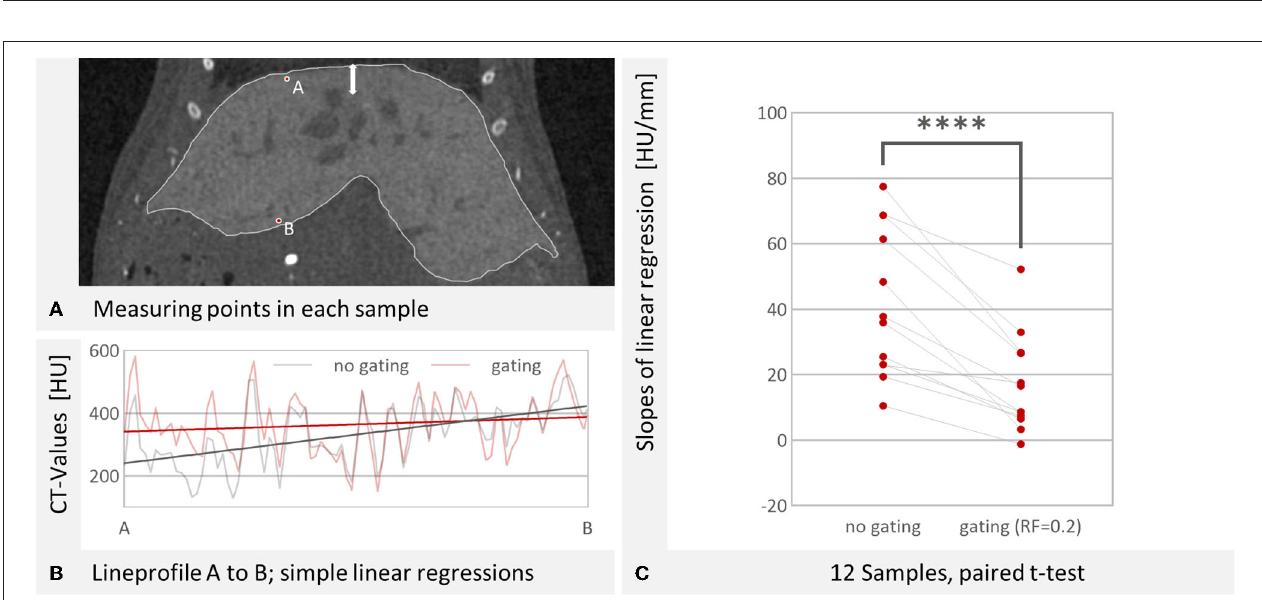
FIGURE 6 | Optimal Rejection Fraction (RF). (A) The best correspondence between the manual evaluation and the algorithmic gating is at RF = 0.2. The success rate is 96.92%. (B) The reconstruction software provides a projection rejection map which is depicted as red stripes over the projection sinogram. The peaks of manually detected motion (see Figure 4B ) match the algorithmically created stripes in the map.